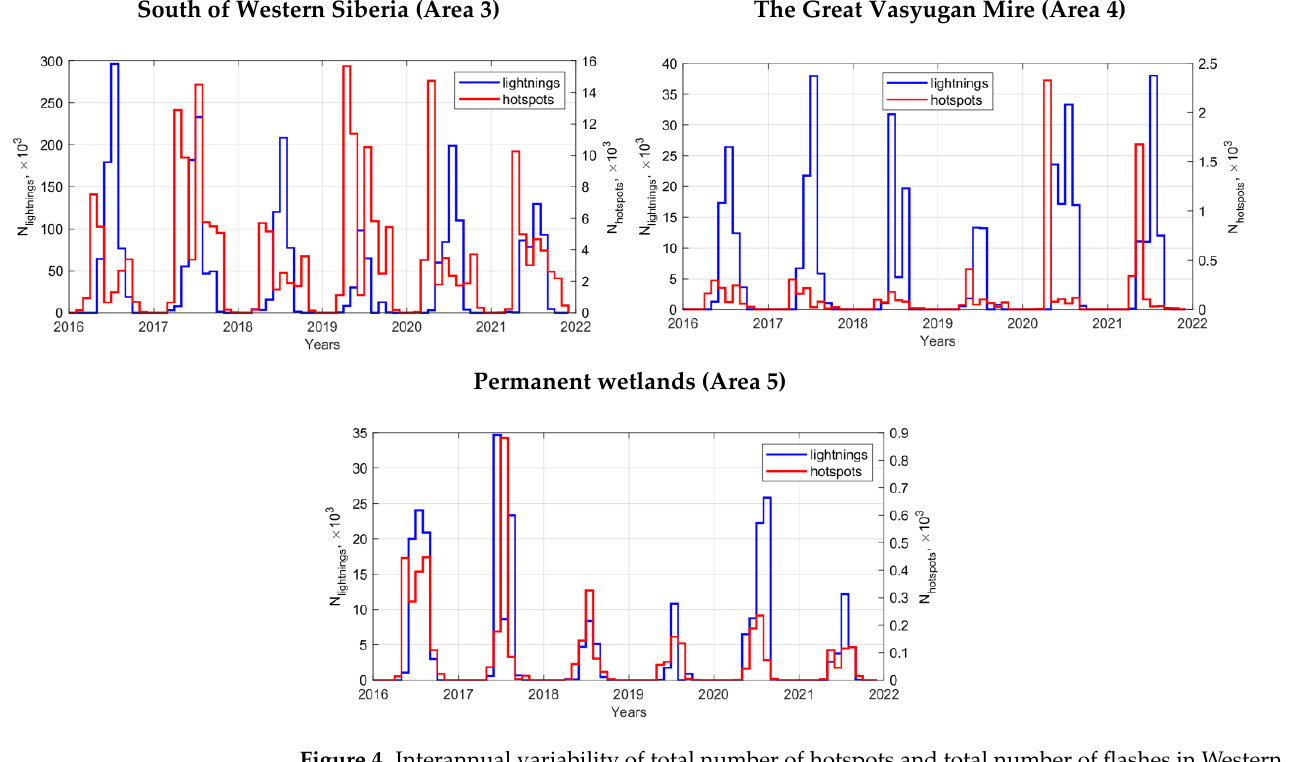
Figure 4. Interannual variability of total number of hotspots and total number of flashes in Western Siberia during the warm season from 2016 to 2021.